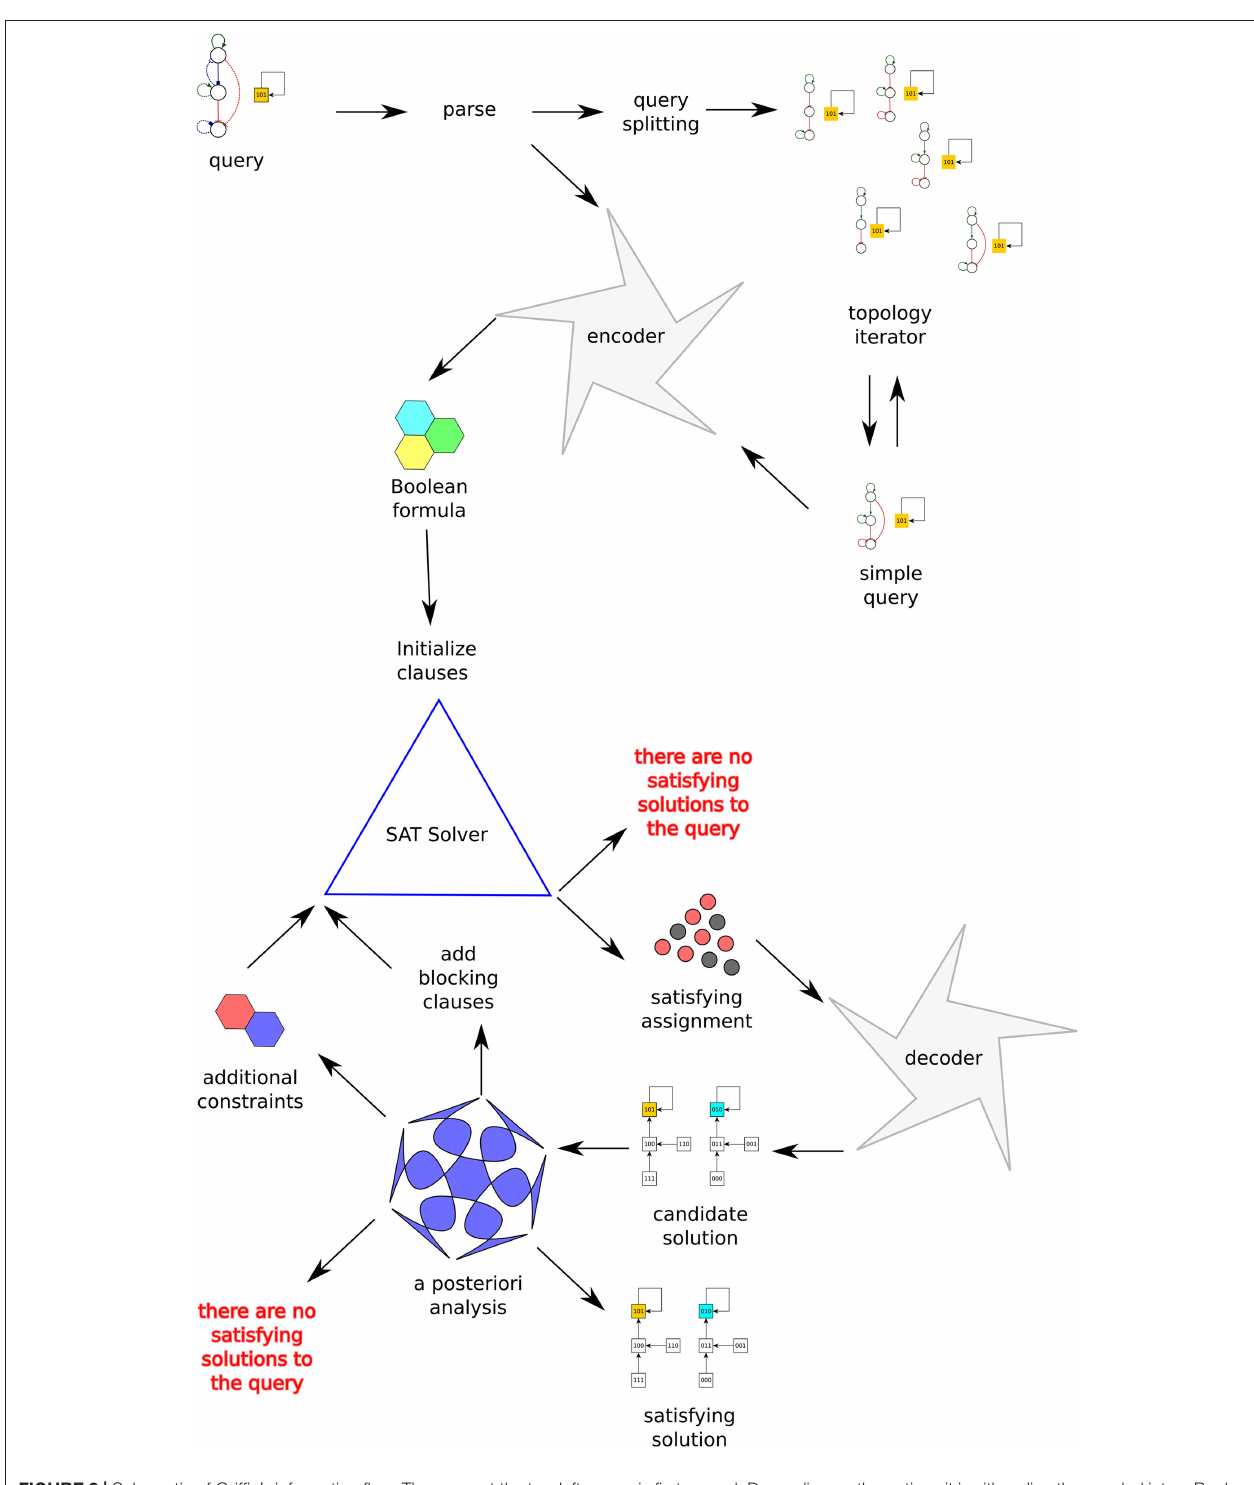
FIGURE 2 | Schematic of Griffin’s information flow. The query at the top-left corner is first parsed. Depending on the options it is either directly encoded into a Boolean formula or split into simpler queries. The Boolean formula is fed into a SAT solver. Each satisfying assignment returned by the SAT solver is decoded into a synchronous Boolean network, a candidate solution. It is also possible that the SAT solver concludes that the formula is a contradiction, that is, there are no synchronous Boolean networks satisfying the query. If a candidate solution is found, blocking constraints prevent finding the same solution twice. Further properties of the candidate solution are verified, possibly resulting in the generation of additional constraints. The runtime blocking analysis concludes with the rejection or acceptance of the candidate solution. If no candidate solution passes the runtime blocking analysis, then Griffin concludes there are no satisfying solutions to the query.